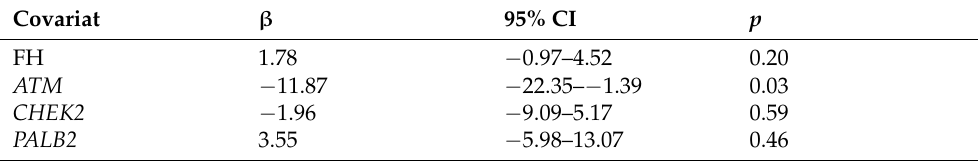
Figure 3. Age at diagnosis (AAD) of male breast cancer in BRCA1/2 -negative individuals based on germline pathogenic variant (PV) status in the CHEK2 , PALB2, and ATM genes. One individual (AAD = 37 years) carried PVs in both CHEK2 and ATM . The term “negative” indicates individuals without PVs in BRCA1/2 , CHEK2 , PALB2 , and ATM . Table 3. Linear regression analysis results with age at first diagnosis (AAD) of male breast cancer (mBC) with years as the outcome in 337 BRCA1/2 -negative patients with mBC. Gene-wise covariates re- fer to pathogenic variant status (1: pathogenic variant, 0: no pathogenic variant). FH = Breast/ovarian cancer family history (1: yes 0: